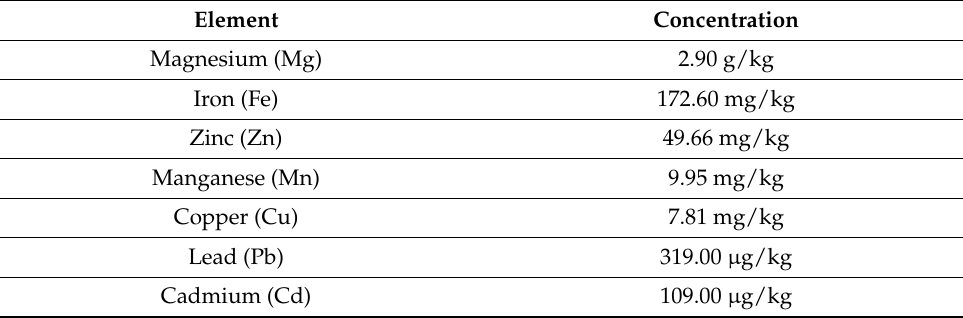
Table 2. Trace elements and heavy metals in S.